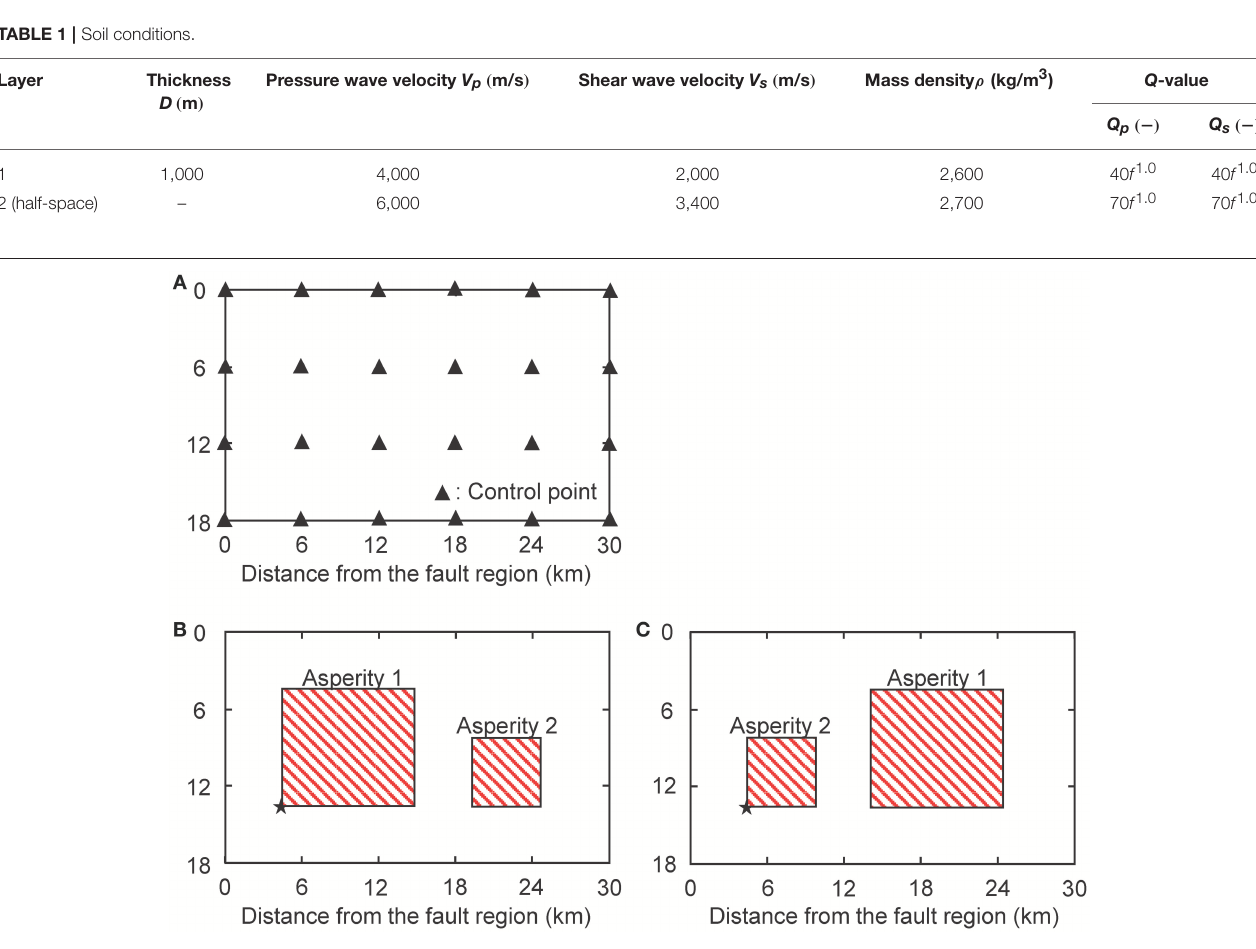
FIGURE 5 | Fault models. (A) Control point for critical model. (B) Recipe model 1. (C) Recipe model 2. *Starting point of fault